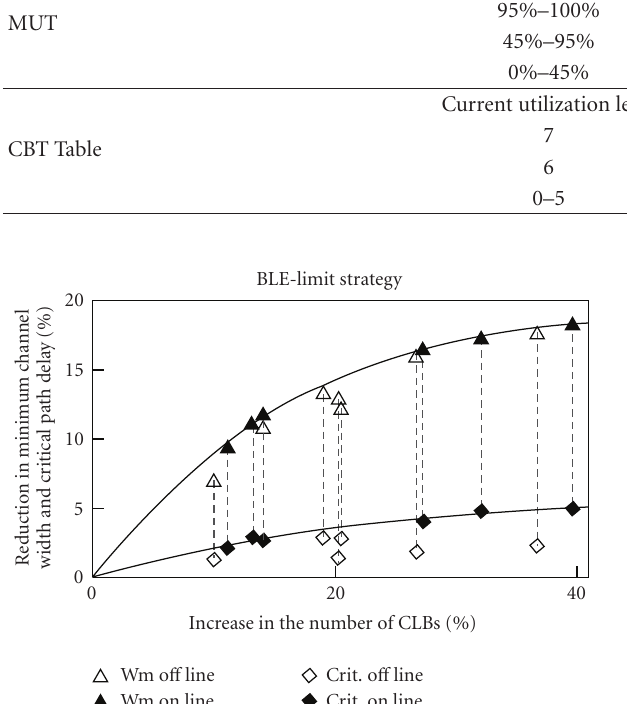
Figure 6: Minimum channel width (Wm) and critical path delay (crit) reduction of T-NDPack with “ BLE-limit ” strategy relative to T-VPack. Triangles represent channel width savings of T-NDPack relative to T-VPack. Diamonds represent critical path delay savings. Solid line represents best line drawn over the data points. Points that are on the solid line are filled (Wm on line and crit. on line). Dotted line represents triangle and diamond data points collected based on the same experimental configuration.